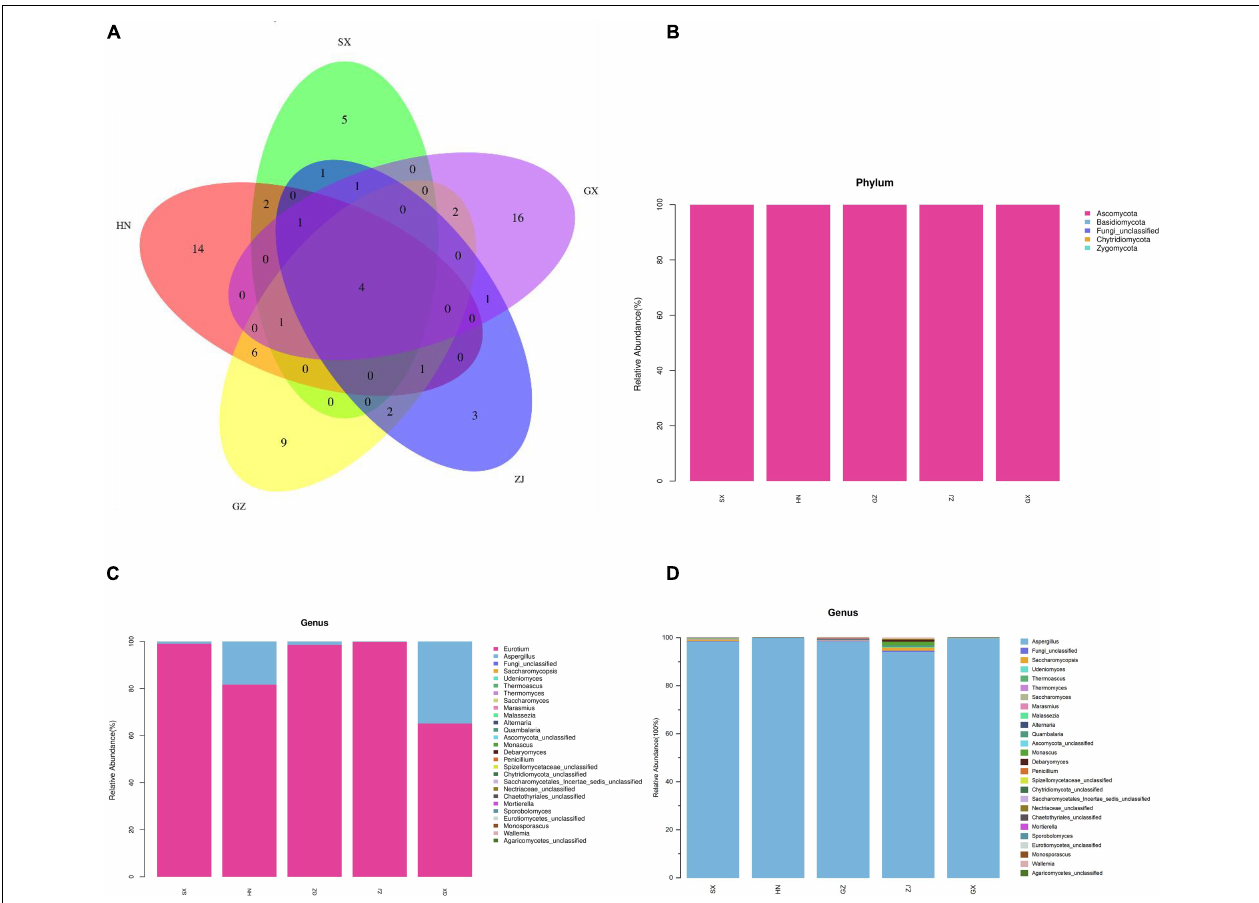
FIGURE 2 | The Venn diagram analysis of fungal community compositions of five Fu brick teas in different regions (A) . The average relative abundance of fungal communities (B) at phylum level; (C) at genus level; (D) genus level with the highest abundance group removed] of FBT